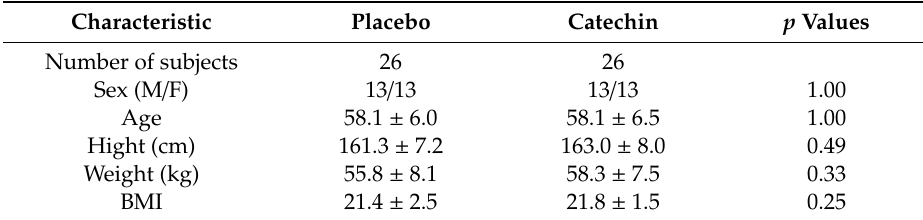
Figure 1. Study flow diagram. Table 1. Clinical characteristics of the patients.